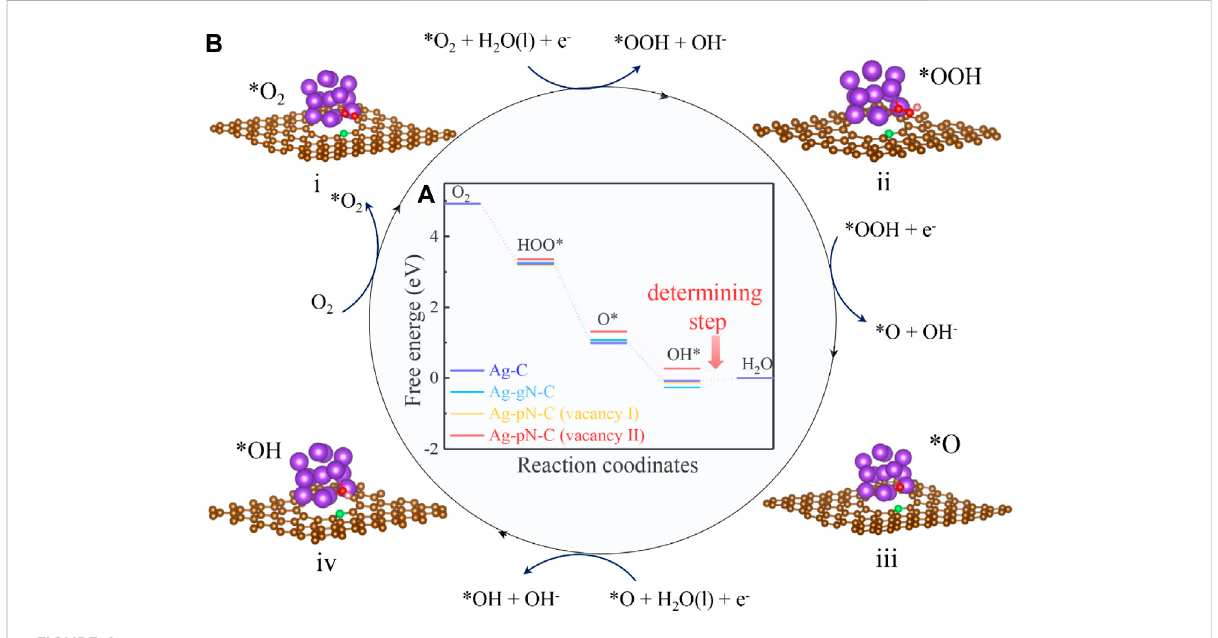
FIGURE 4 DFT calculations (A) Free energy diagram of different samples at different optimized adsorbed reaction sites; the oblique lines and corresponding value shows the RDS and energy barriers of catalysts. (B) Favorable reaction pathway from i to iv of Ag-N-C. (brown ball: C atoms, violet ball: Ag atoms, red ball: O atoms, green ball: N atoms, pink ball: H